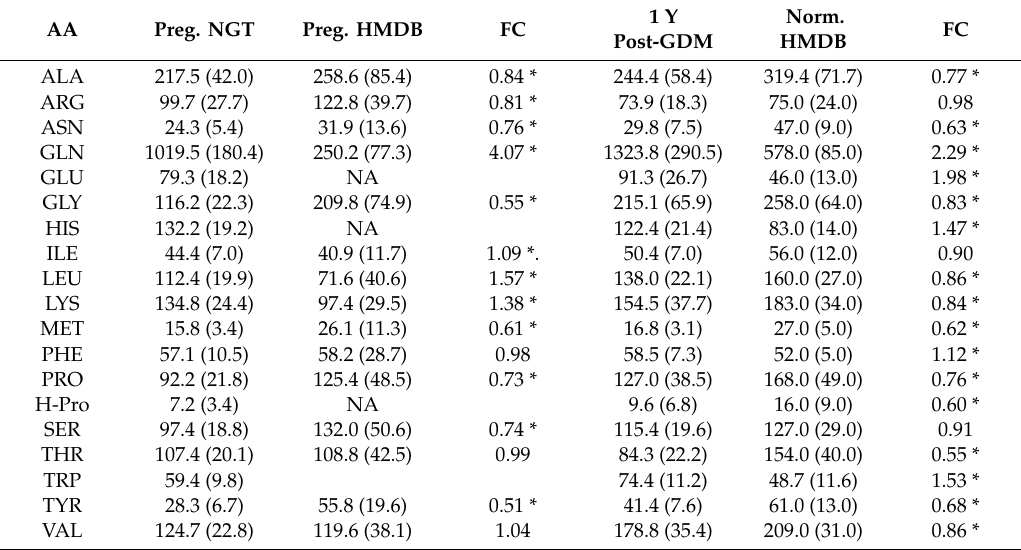
Table 6. Comparison of mean plasma concentrations of AA in NGT. One year postpartum group with external data (HMDB) [33] concerning the pregnant and non-pregnant healthy